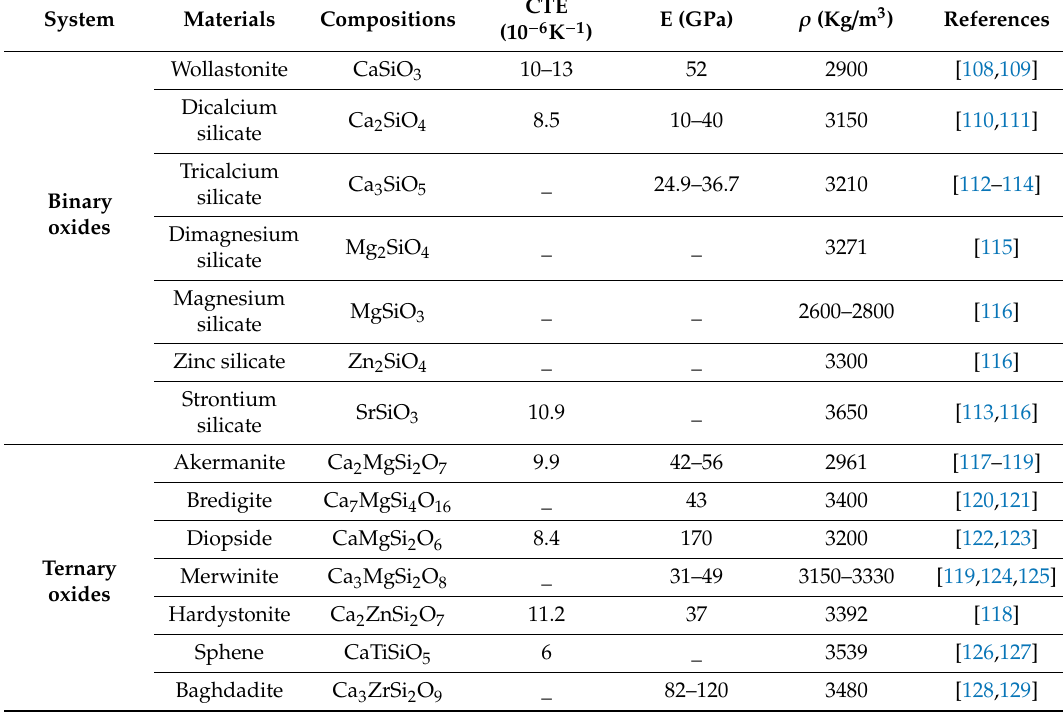
Table 3. Common silica-based ceramics used in medical devices and their composition, mechanical, thermal and physical properties (dense